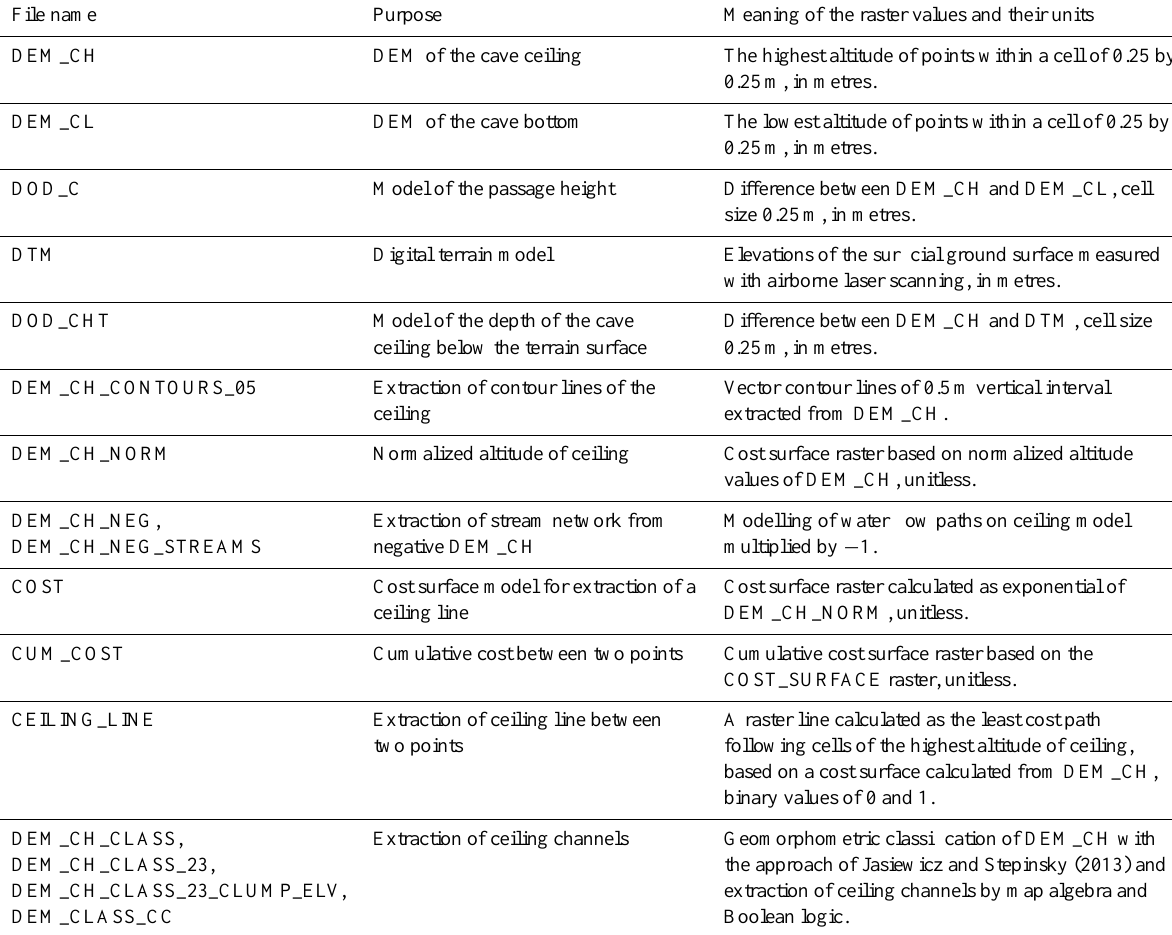
Table 2. Summary of raster data derived from 3-D point cloud in LAStools and GRASS